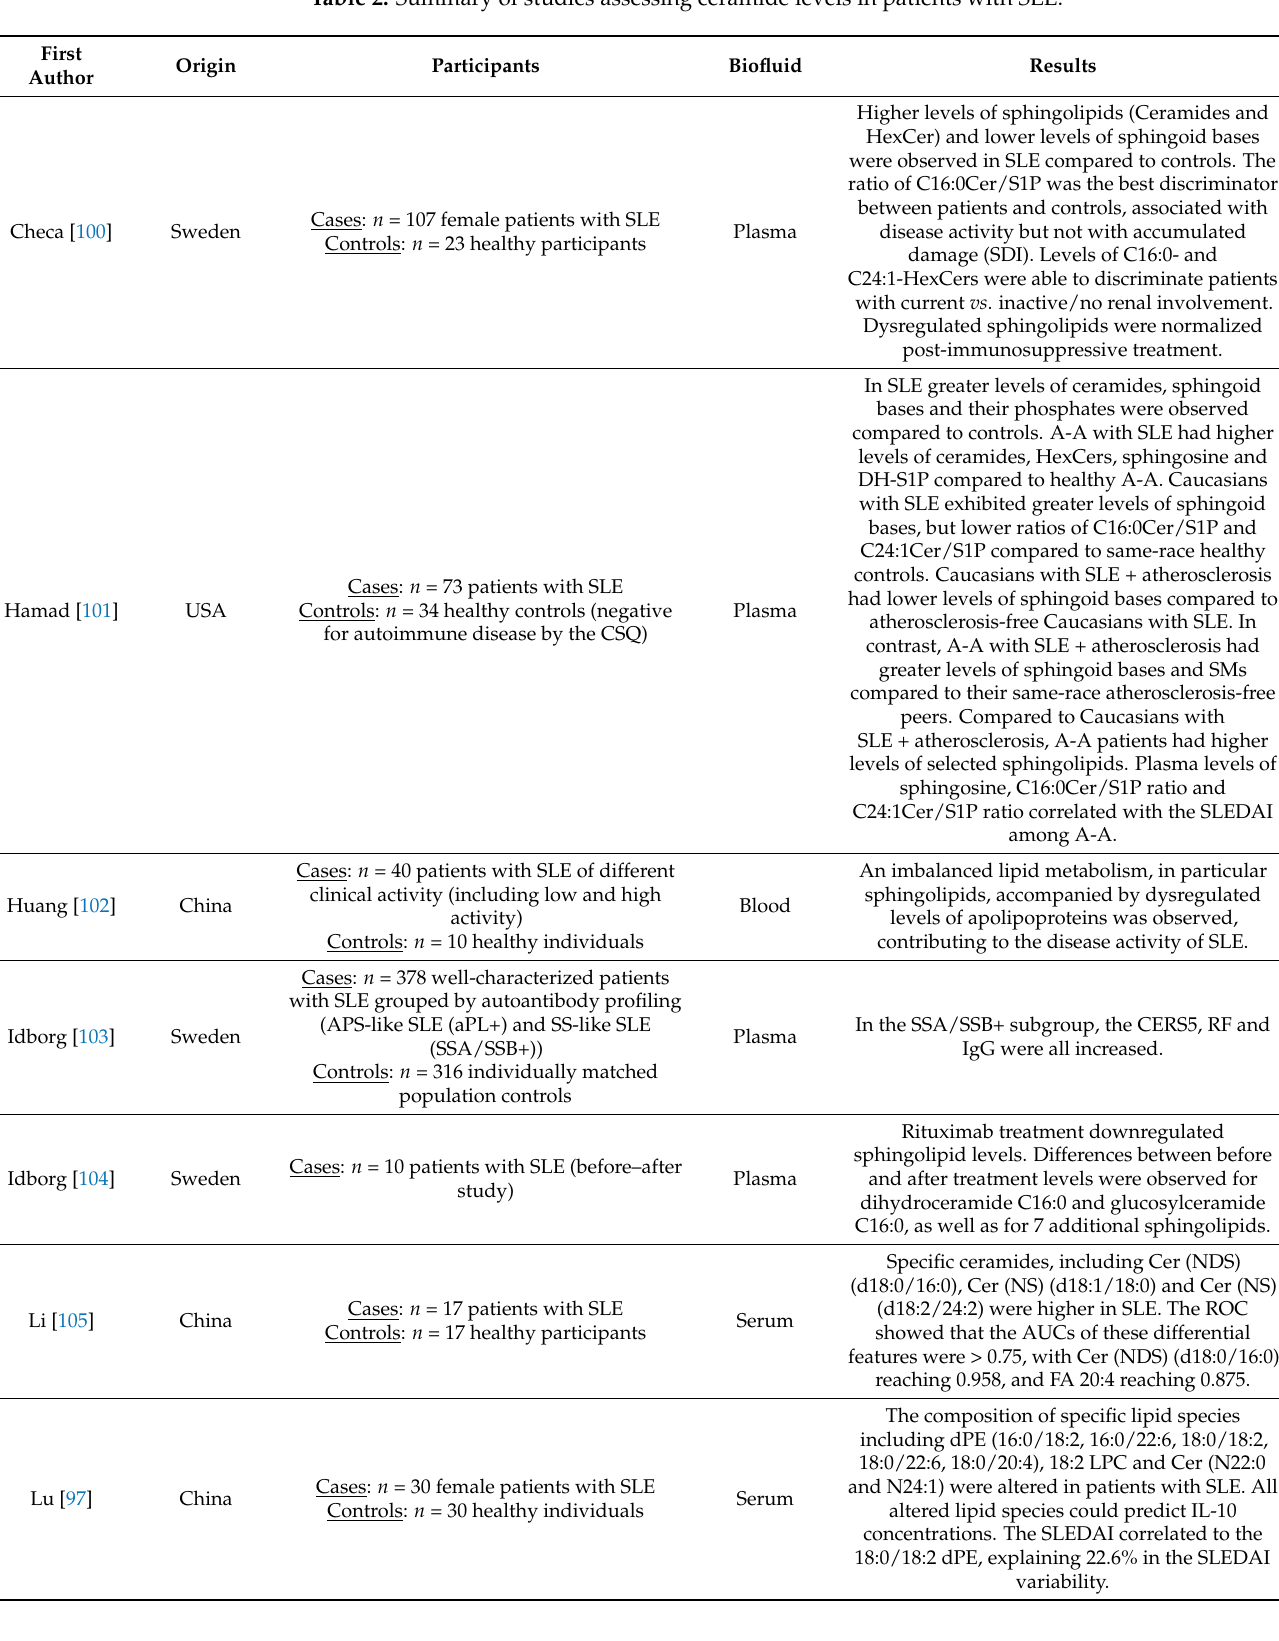
Table 2. Summary of studies assessing ceramide levels in patients with